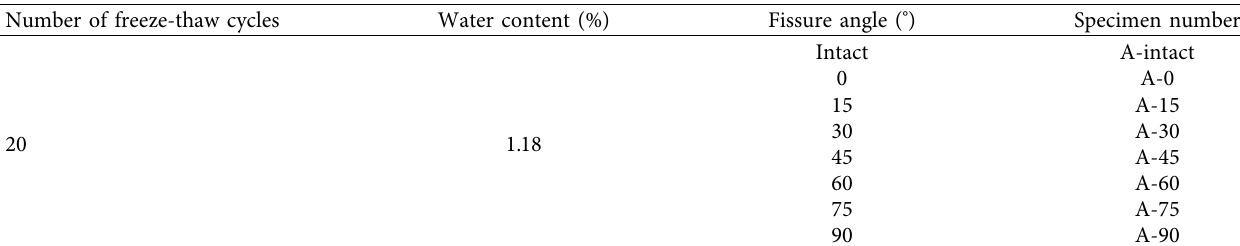
Table 1: Sample number.